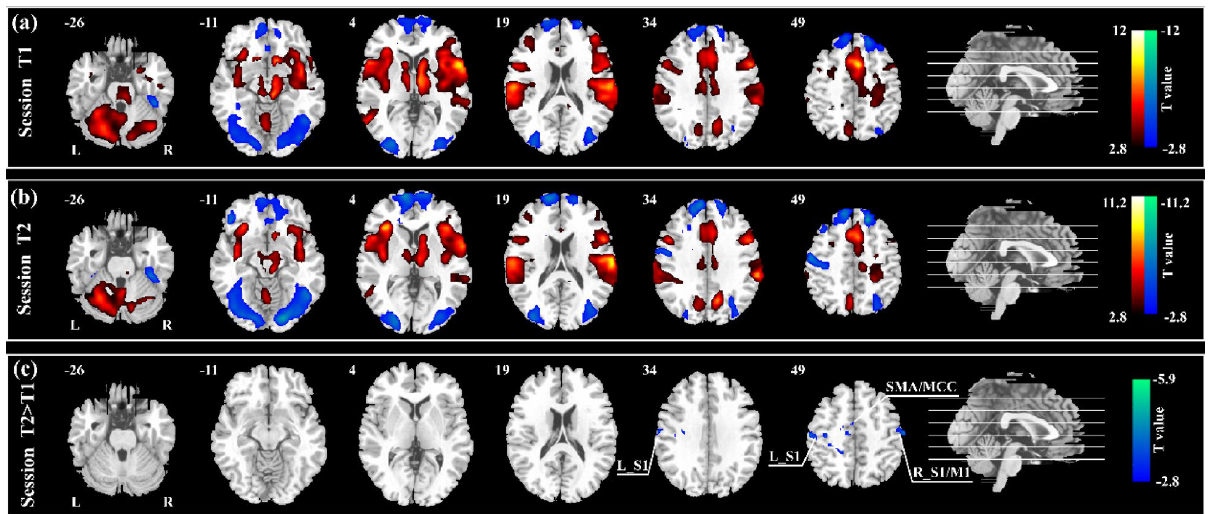
Figure 1. Brain responses to nociceptive laser stimuli. For both T1 session ( a ) and T2 session ( b ), nociceptive stimuli elicited significant brain responses in the periaqueductal gray, thalamus, primary somatosensory cortex (S1), secondary somatosensory cortex, insula, and anterior cingulate cortex. ( c ) Laser-evoked brain responses were significantly smaller in bilateral S1, right primary motor cortex (M1), supplementary motor area (SMA), and middle cingulate cortex (MCC) during T2 session than T1 session. L left hemisphere; R right hemisphere. The resulting t-statistic maps were thresholded at p < 0.005, cluster-corrected at family wise error of p < 0.05. The images were created by using the MRIcron software (v1.0.20190902, https ://www.nitrc .org/proje cts/mricr on).